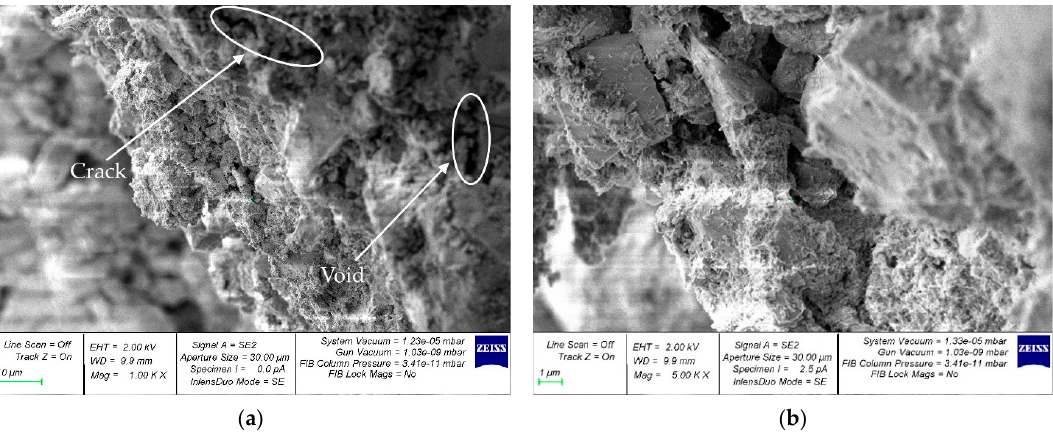
Figure 11. Micrographs of the structure of samples of the hardened cement paste of the control composition (containing no walnut shell): ( a ) 1000× ( b ) 5000×.